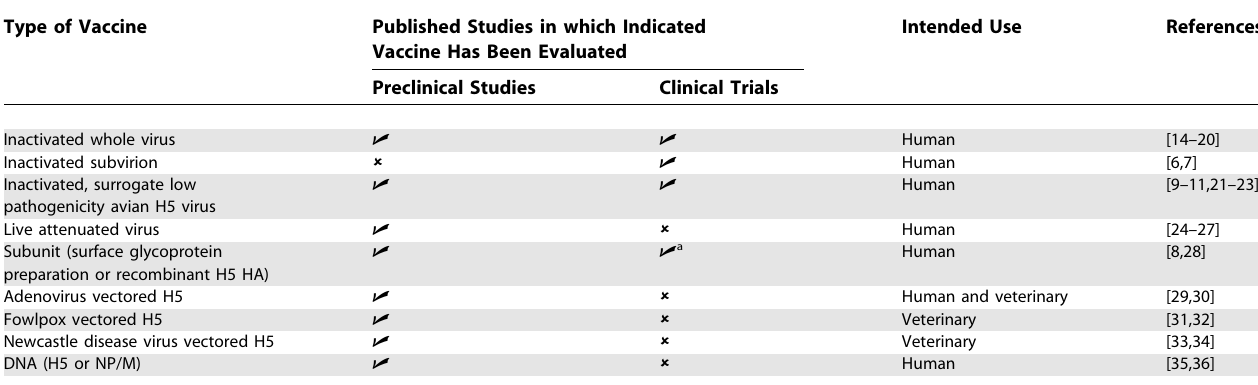
Table 1. Vaccine Strategies against H5N1 Influenza that Have Been Evaluated in Preclinical and Clinical Studies Type of Vaccine